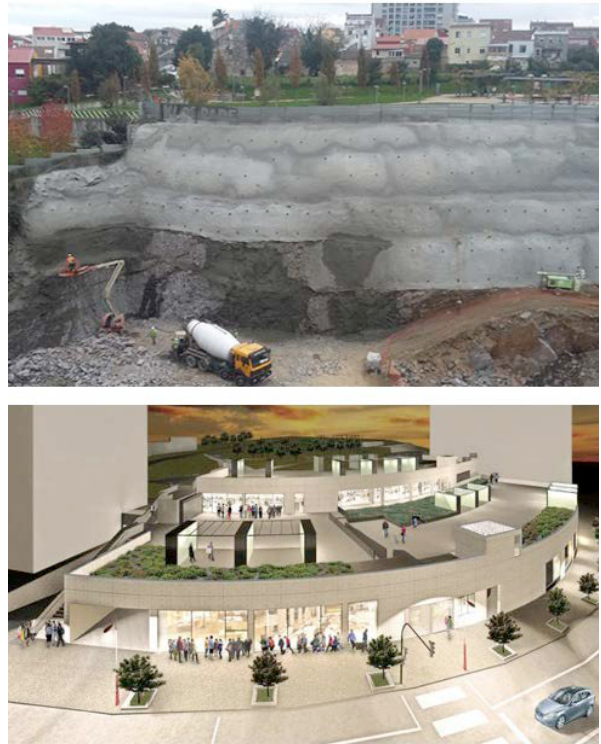
Figure 4. Overview of the project area. (a) View of shotcrete- pumping truck in operation on wall and excavation works in progress. (b) Impression of the new shopping mall (Source: